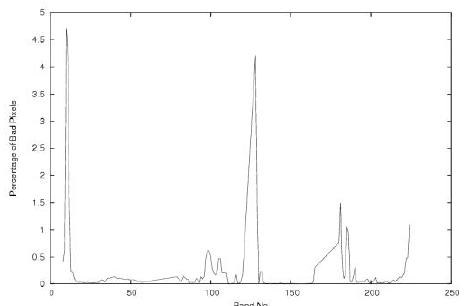
Fig 4 Plot of percent bad pixel versus wavelength